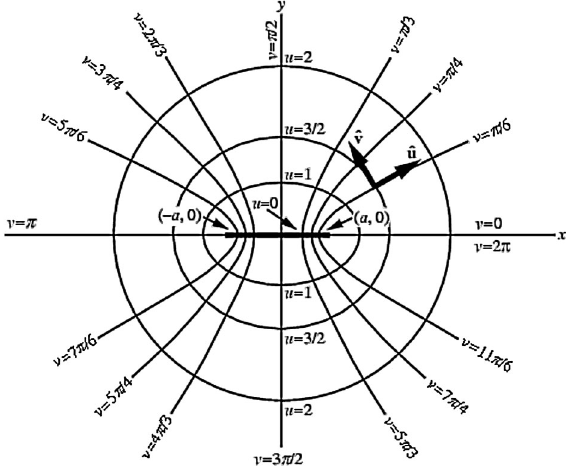
FIG. 4. Elliptical coordinates showing contours of constant u and constant v [12]. The foci are at ð(cid:7) a; 0 Þ , and in our case a ¼ f .